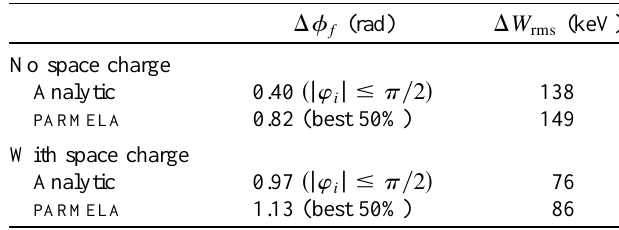
TABLE V. Comparison of analytic model and PARMELA com-